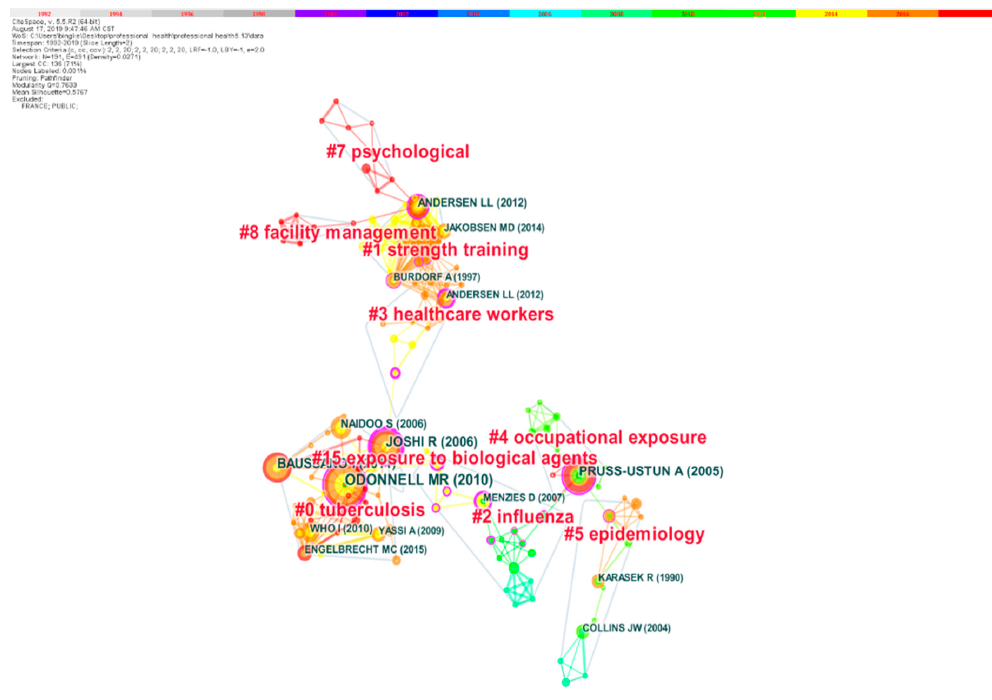
Figure 7. Document co-citation network.